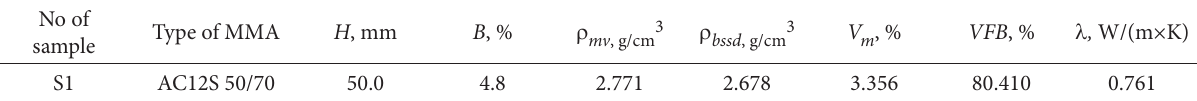
Table 1. Characteristics of sample AC12S 50/70 for wearing layer, designated to test changes in the temperature No of sample